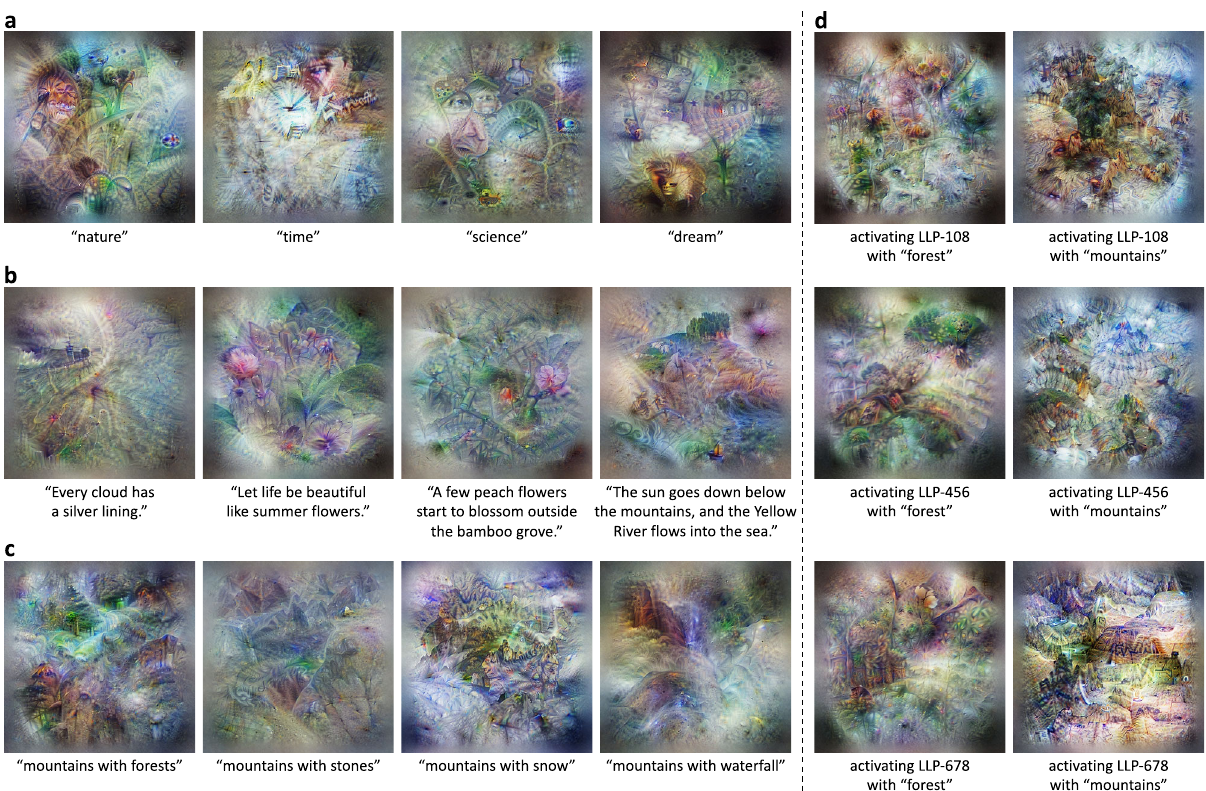
Fig. 2 Network and neuron visualizations of our BriVL ’ s imagination. a Visualizations of the fi nal embedding layer of BriVL w.r.t. high-level concepts. b Visualizations of the fi nal embedding layer of BriVL w.r.t. free-form text inputs. c Visualizations of the fi nal embedding layer of BriVL with semantic restrictions related to “ mountains with ” . d Visualizations for different neurons of BriVL with semantic restrictions “ forest ” and “ mountains ”